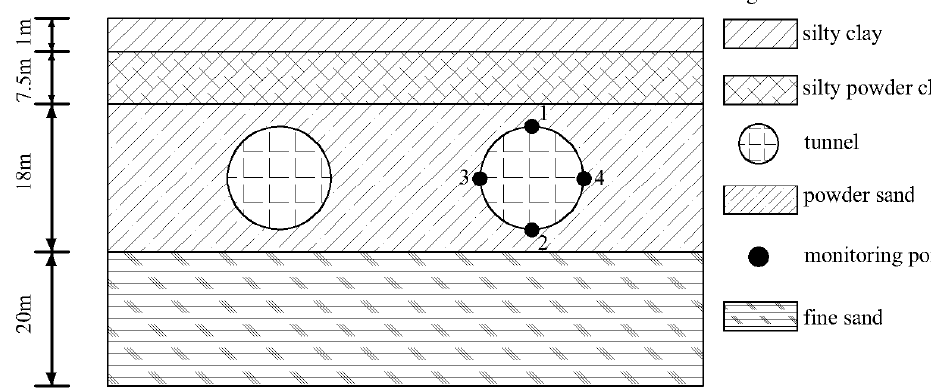
Figure 2. Geological profile of the site.